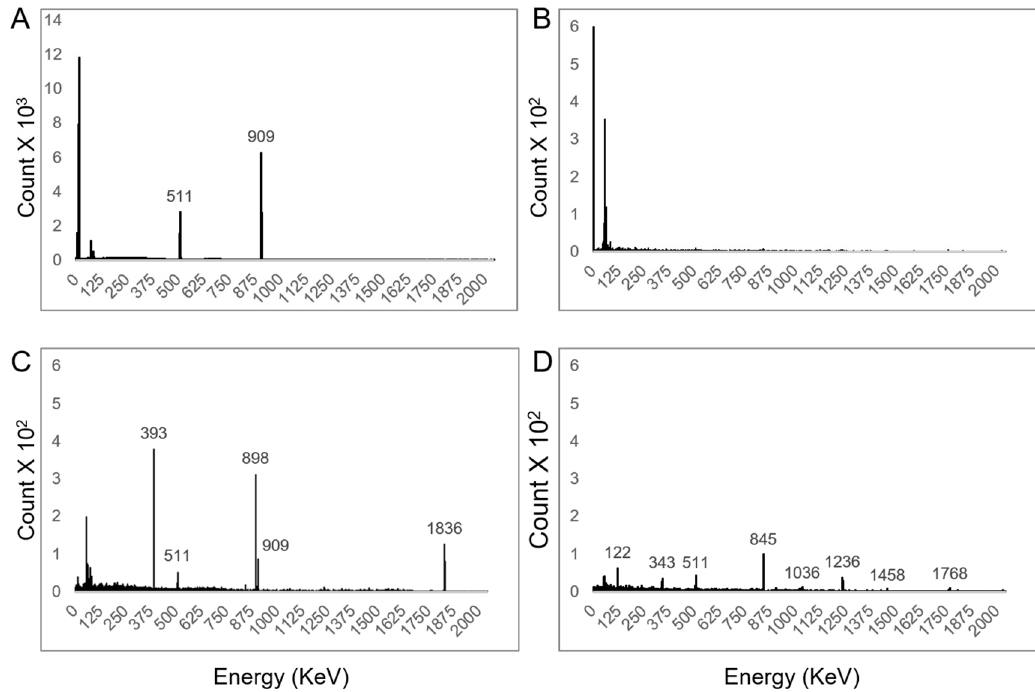
Figure 5. Representative γ -spectra of 89 Zr performed after ( A ) 89 Zr purification using 89 Y-foil and irradiation performed at 11.3 MeV, ( B ) six months, using 89 Y-foil and irradiation performed at 11.3 MeV, ( C ) six months, using 89 Y-foil and irradiation performed at 13.3 MeV, and ( D ) six months, using 89 Y-pressed powder and irradiation performed at 11.3 MeV. Samples were measured using a HPGe detector.